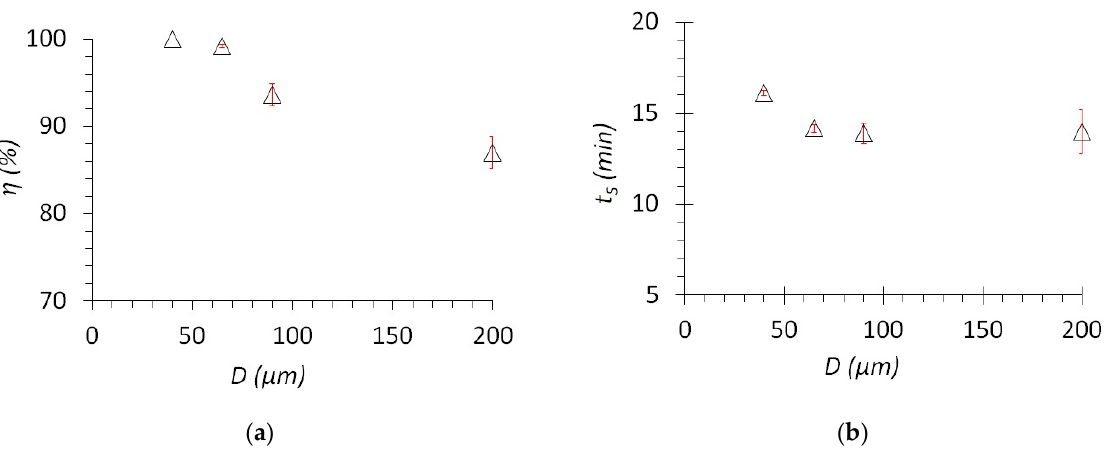
Figure 6. ( a ) Dependence of separation efficiency on the pore size of a metal mesh and ( b ) depend- ence of separation time on the pore size of a metal mesh.